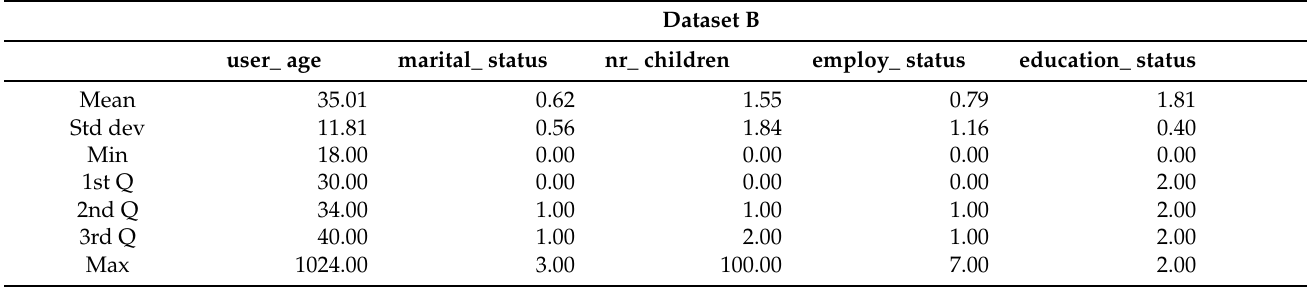
Table 3. Table of descriptive statistics for dataset